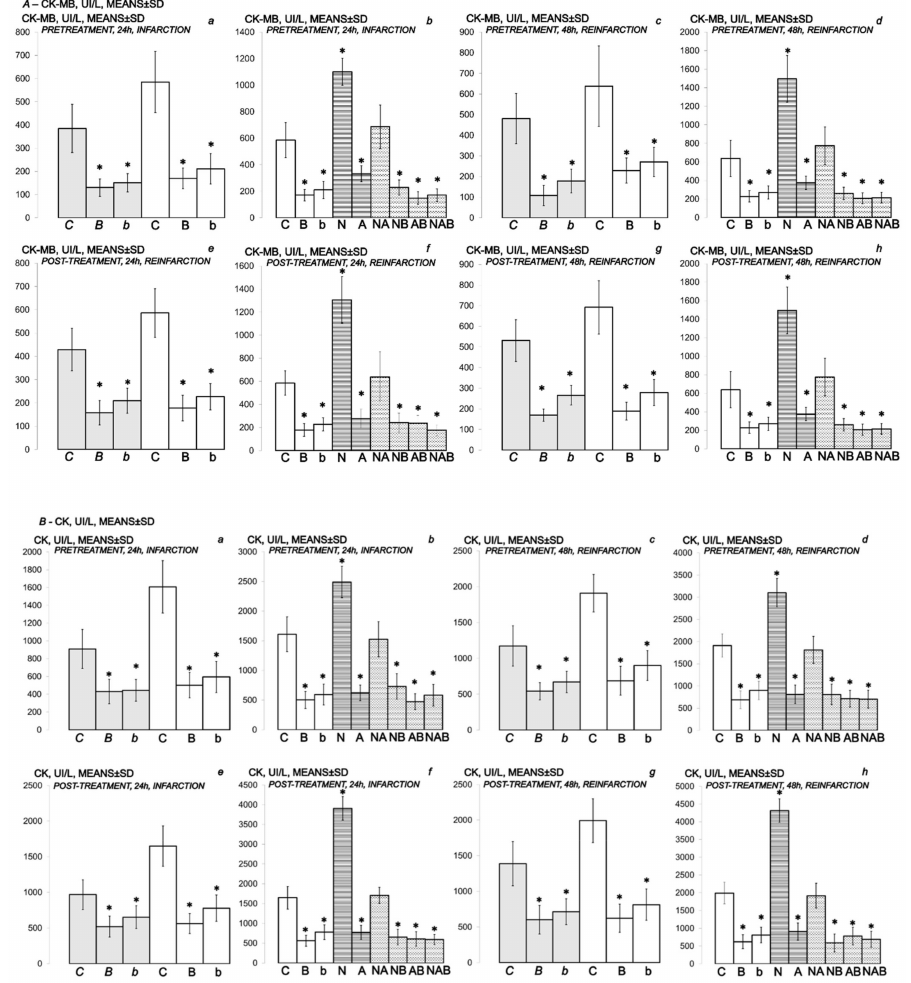
Figure 10. ( A , B ) Myocardial infarction (one isoprenaline challenge) and re-infarction (two isopre- naline subsequent challenges) in isoprenaline-treated rats (75 mg/kg sc (gray bars), 150 mg/kg sc (white bars)). Serum values of cardioselective enzymes A-CK-MB (UI/L) and B-CK (UI/L). Rats treated with the smaller dose of isoprenaline, 75 mg/kg sc (gray bars, italic letters), received medi- cation (BPC 157 (10 ng/kg ( b ), 10 µ g/kg ( B ) i.p. or saline (5 mL/kg i.p. ( C )). Rats treated with the higher dose of isoprenalines, 150 mg/kg sc (white bars, normal letters), received medication (BPC 157 (10 ng/kg (b), 10 µ g/kg (B) i.p. or saline (5 mL/kg i.p. (C)) or L-NAME (5 mg/kg i.p. (N)), L-arginine (200 mg/kg i.p. (A)) (horizontal line bars) or these agents in combination (L-NAME + L-arginine (NA), L-NAME + BPC 157 (NB), L-arginine + BPC 157 (AB), L-NAME + L-arginine + BPC 157 (NAB)) (dashed horizontal lines bars). Therapy was given (i) 30 min before isoprenaline ( PRETREATMENT ), prophylactic regimen ( a – d ), or, alternatively, (ii) at 5 min after isoprenaline (75 mg/kg s.c. or 150 mg/kg s.c.), at day 1 and at day 2 ( POST-TREATMENT , therapeutic regimen ( e – h )). Ten rats per each experimental group. * p < 0.05 vs. control, at